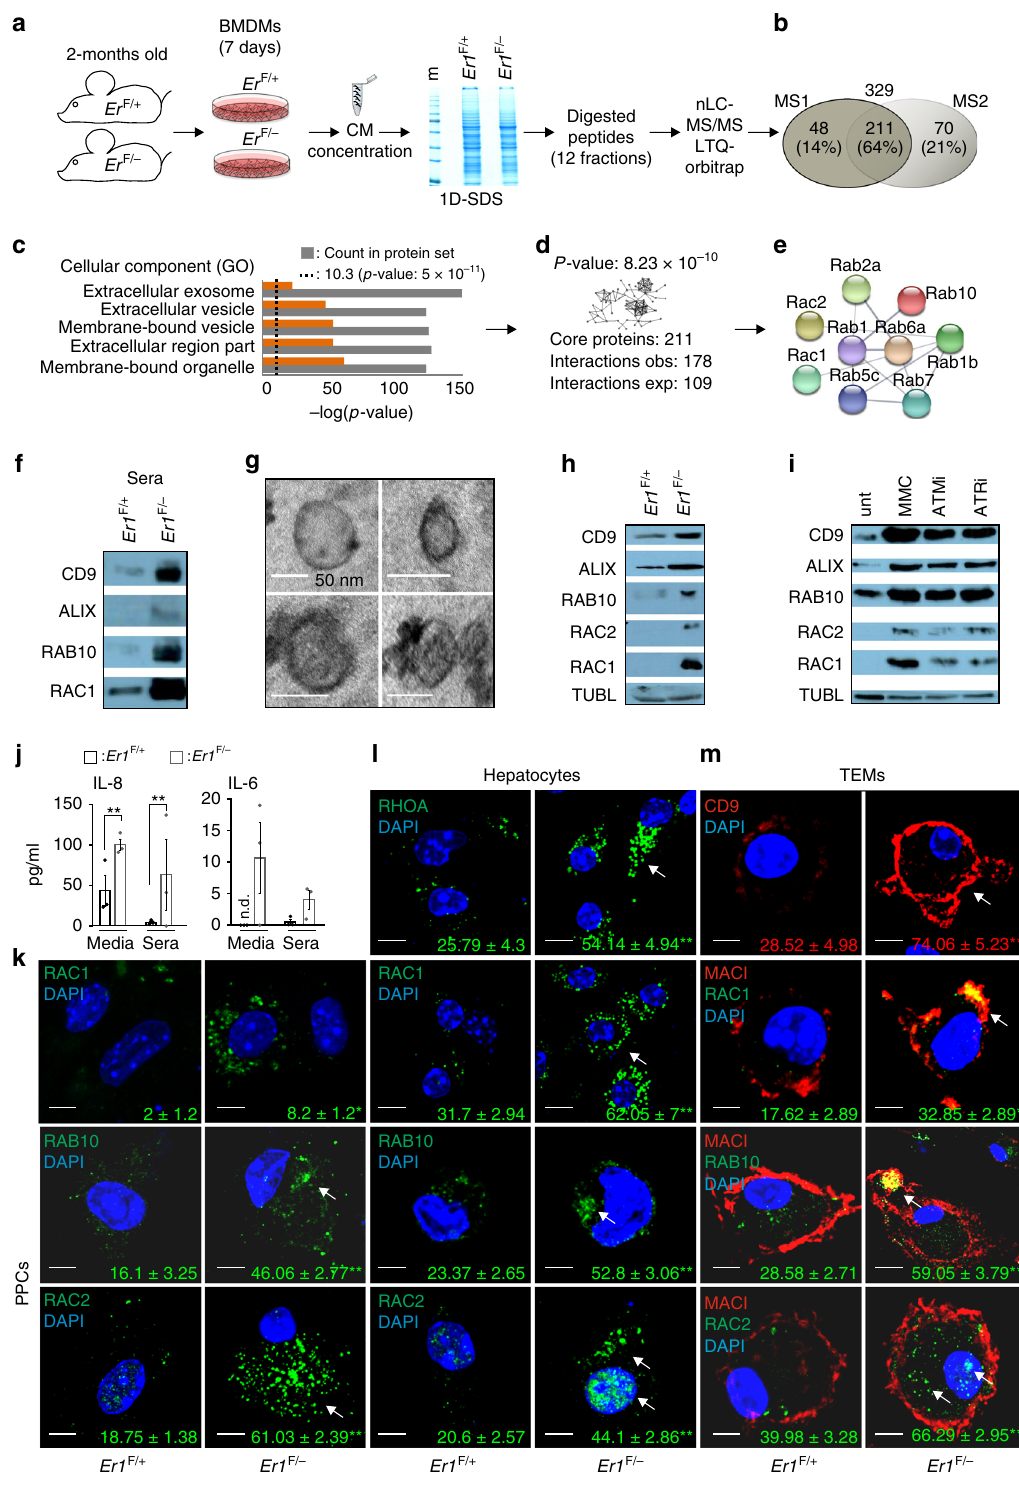
Er1 − / − or wt. MEF-derived EVs (Fig. 8e; as indicated). In agreement, wt. PPCs treated with Er1 F/ + or Er1 F/ − EVs derived from either macrophages or monocytes and with EVs derived from Er1 − / − or wt. adipocytes or MEFs leads to the accumulation of GLUT1 and iNOS (Supplementary Fig. 10A) and to the 2- NBDG uptake (Supplementary Fig. 10B) only in recipient cells exposed to Er1 F/ − macrophage-derived